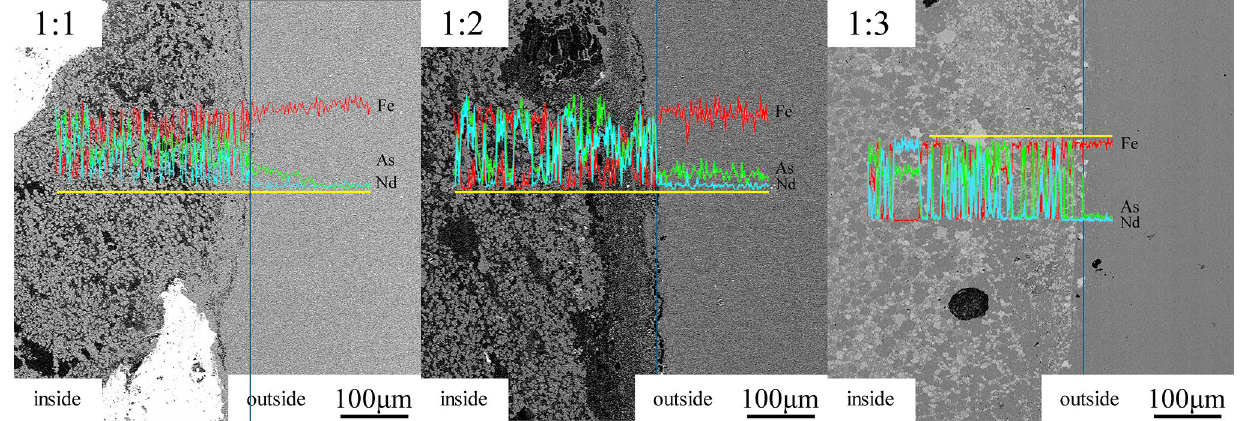
Figure 5. Sweep spectrum of the edge line of the cylinder samples at different atomic ratio.